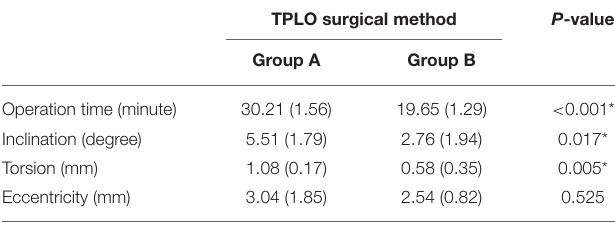
TABLE 1 | Comparison of the operation time, osteotomy inclination angle, osteotomy torsion, and distance of eccentricity according to the surgical